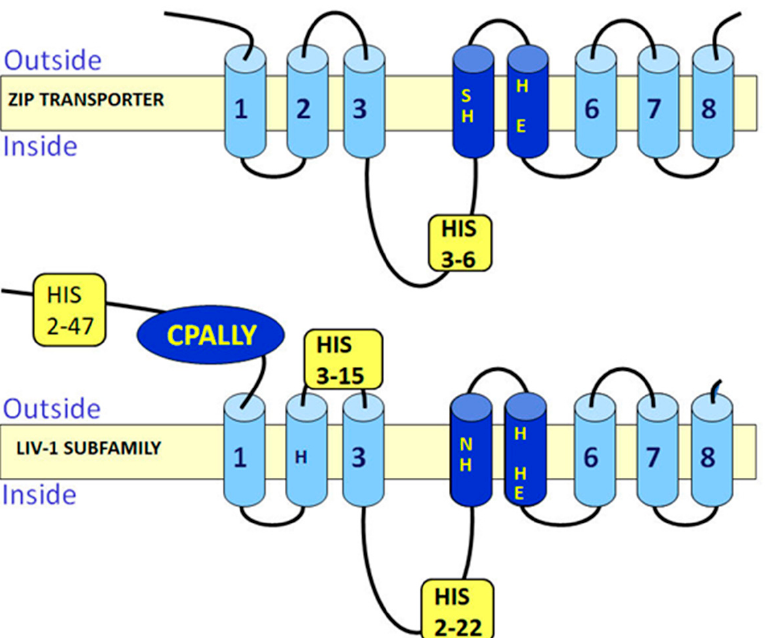
Figure 3. Schematic comparing the predicted structure of the LIV-1 subfamily of ZIP transporters with other ZIP transporters. The LIV-1 family contains the conserved HEXPHE motif in TM5 as well as a conserved His residues in TM2 and TM4. They also have many more His residues amassing 76 residues in ZIP10 alone which are spread between three regions, the N-terminus, the extracellular loop between TM2–3 and the intracellular loop between TM3–4. Additionally, the LIV-1 family members that move to the plasma membrane also have a conserved CPALLY motif on the N-termi- nus.